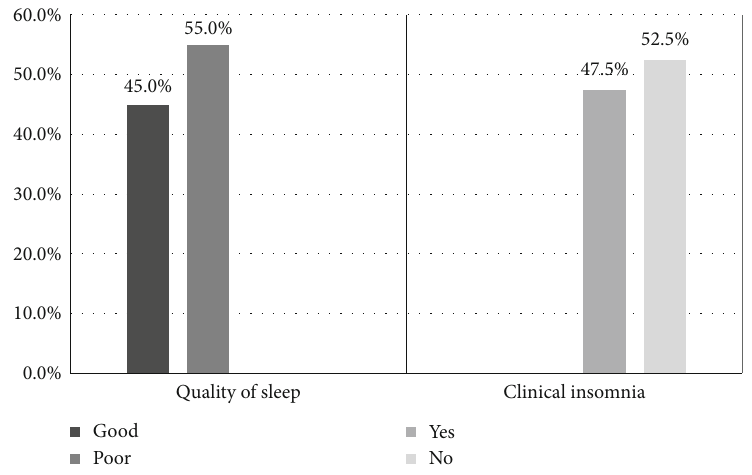
Figure 1: Distribution of clinical insomnia and quality of